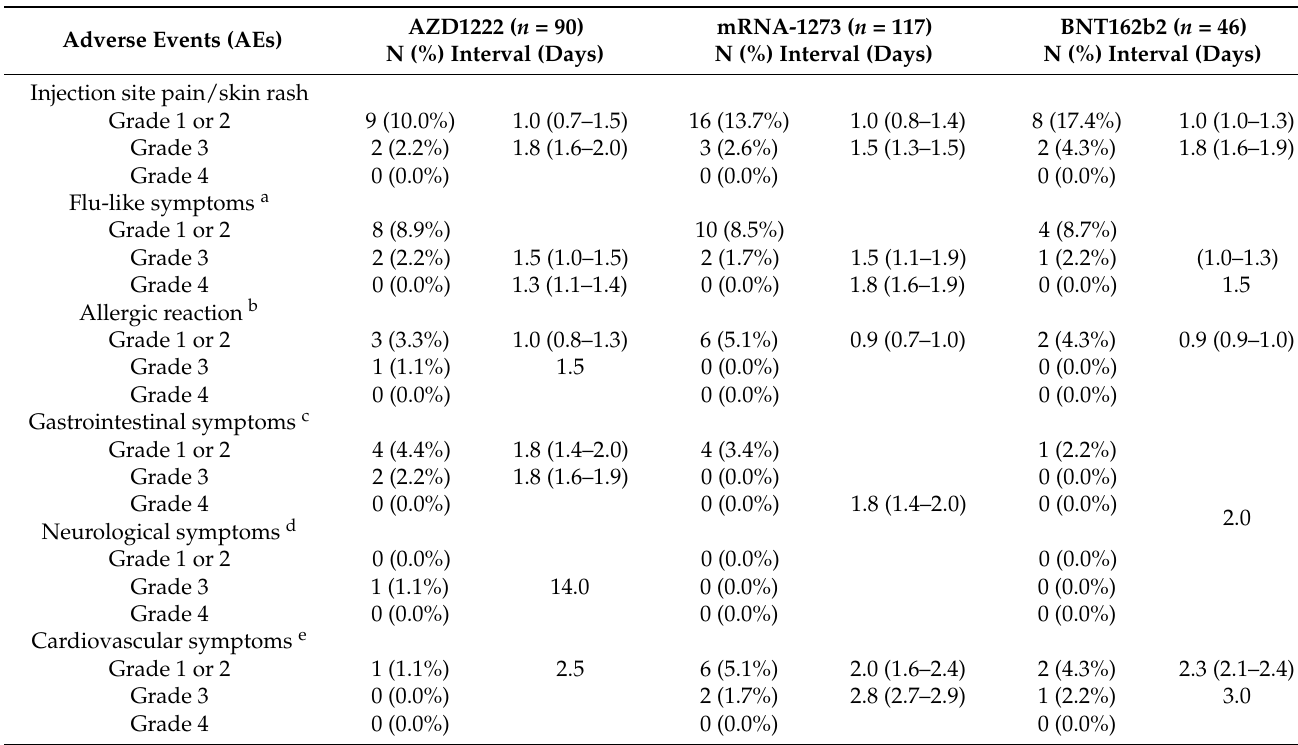
Table 3. The adverse effects of vaccination with AZD1222, mRNA-1273, or BNT162b2 in patients with immune-mediated inflammatory